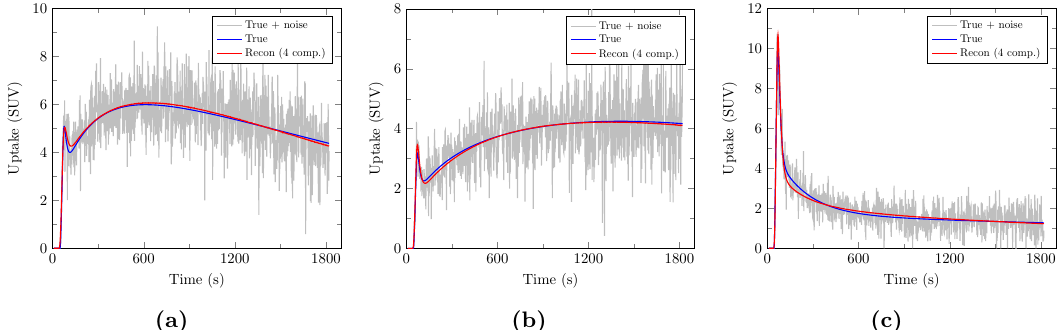
Figure 5. Examples of PCA-reconstructed synthetic evaluation TACs with 4 components for a realistic noise level of 1.5. Noisy synthetic TACs are depicted in light gray along with their corresponding true unnoisy TACs (blue) and PCA-denoised TACs with 4 components (red) for a decreasing ( a ), increasing ( b ), and arterial ( c )